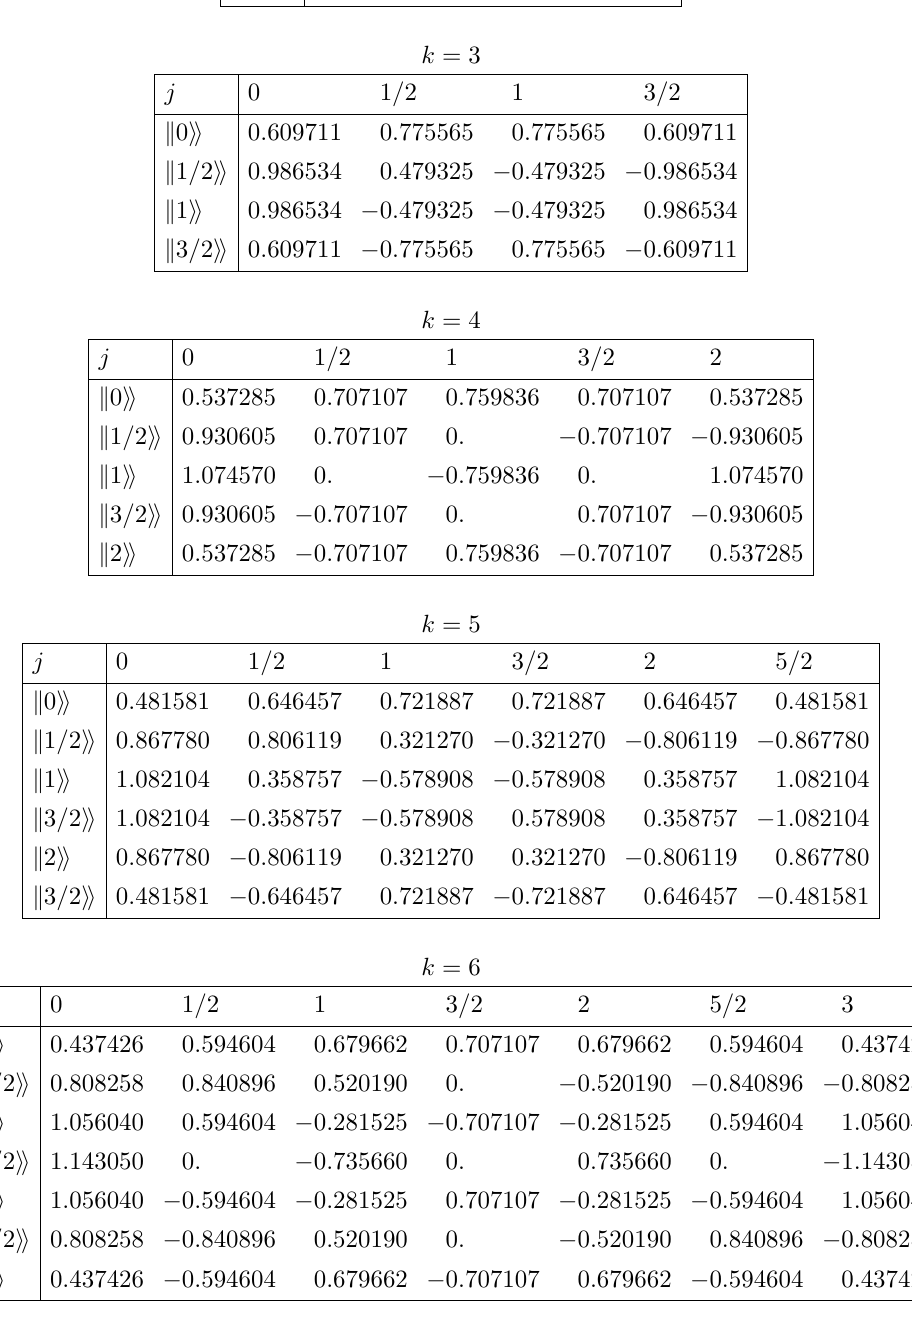
of SU(2) Cardy boundary states from k = 2 to k = 6 J